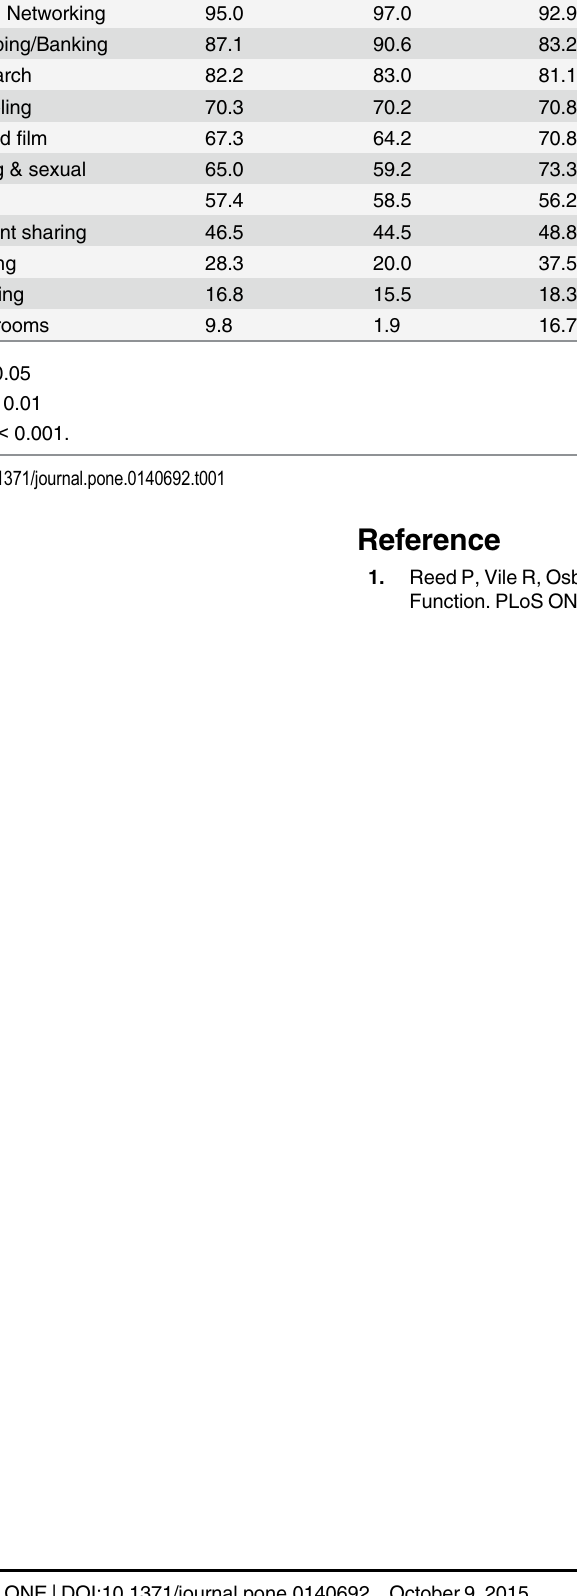
Table 1. Percentage of sample visiting websites of various forms, along with percentage male and females, and younger and older, participants visiting sites along with Phi coefficients.